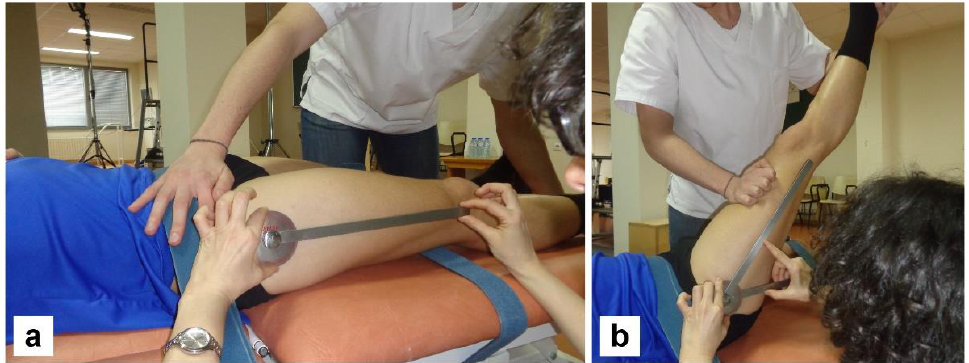
Figure 4. Start ( a ) and end ( b ) positions of the straight leg raised (SLR) test, performed in the supine position.